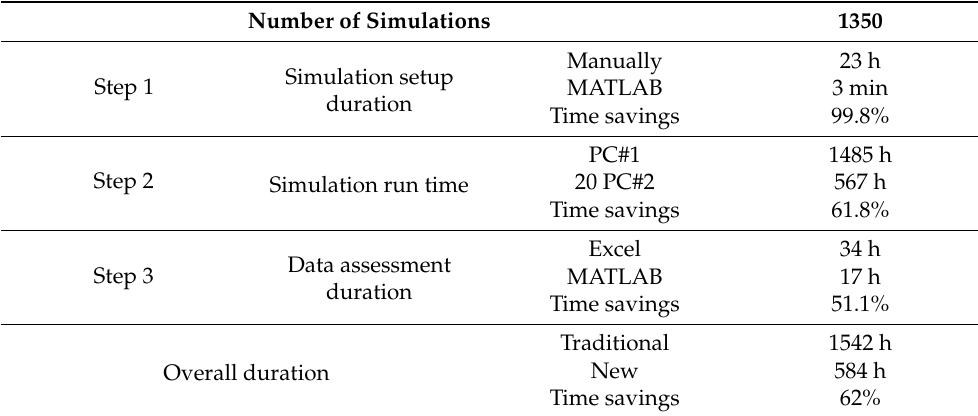
Table 3. Time savings achieved using the developed methodology for the examples presented in Section